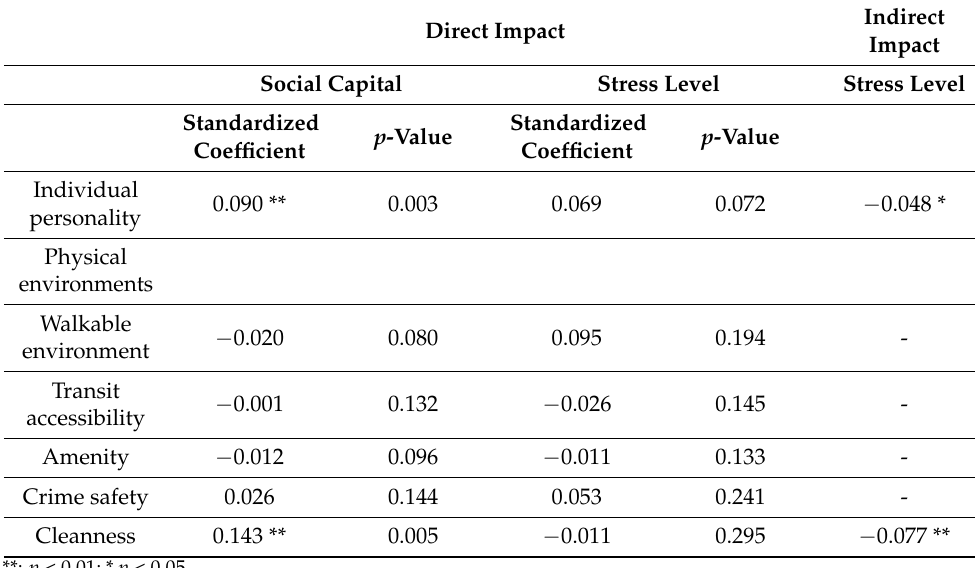
Table 4. The direct and indirect relationships between individual personality, physical environments, social capital, and stress